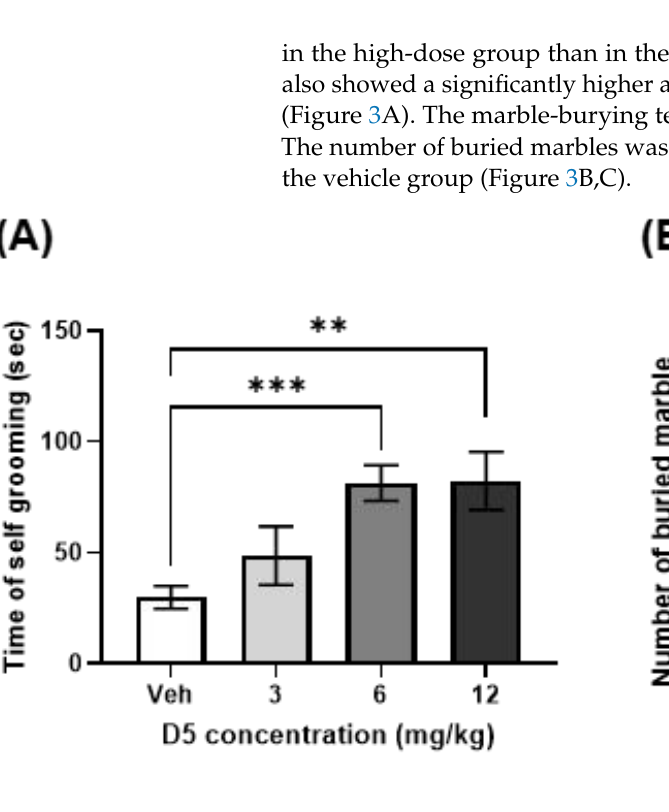
6 of 14 Figure 2. Discrimination of D5 as a developmental neurotoxicant by DNT: ( A ) cell survival curve of 46C; ( B ) logarithmic curve of the fluorescence intensity of GFP in neurosphere.